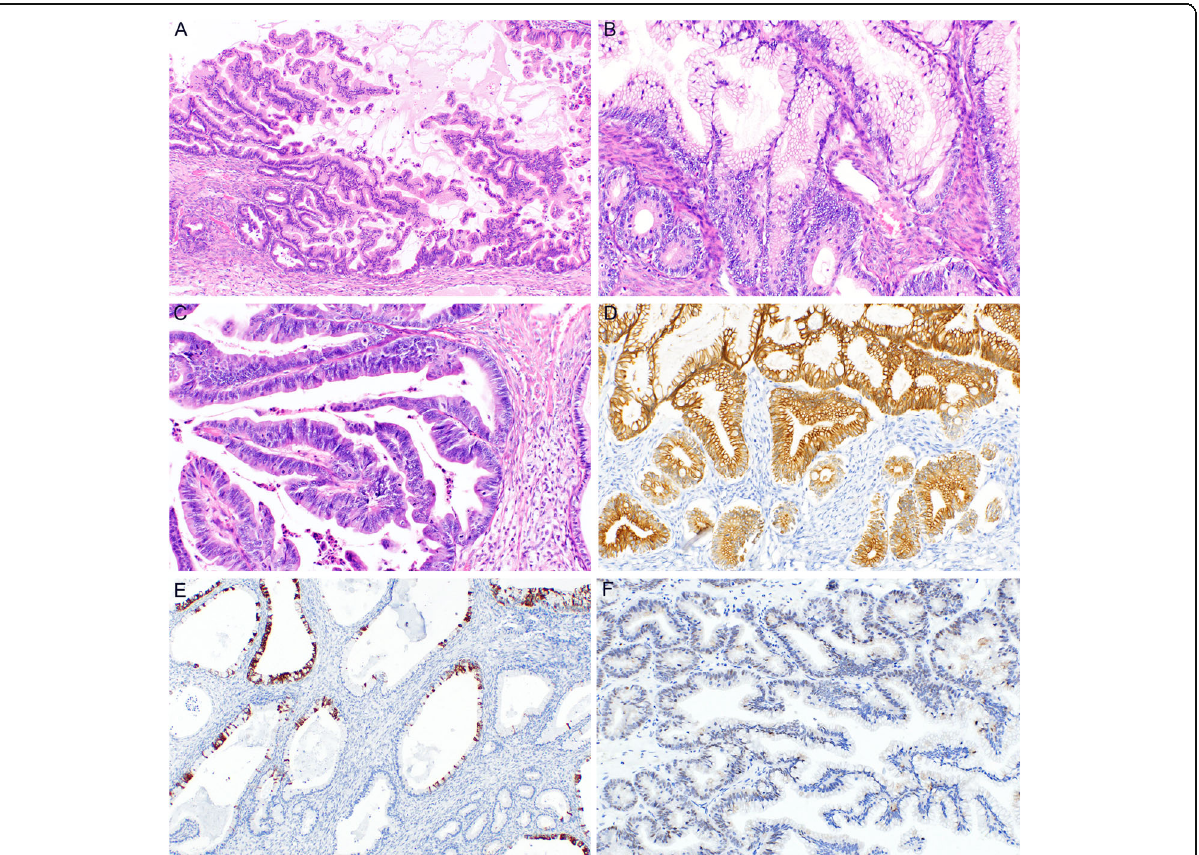
Fig. 1 Mucinous borderline tumor (MBT). Intracystic epithelial proliferation of gastrointestinal-type epithelium with villoglandular arrangement ( a ) (H&E, 100x). Tumor structures showing increased proliferative activity in the crypts with mitoses and mild nuclear atypia, whereas other parts of the villoglandular structures consist of more mature cells ( b ) (H&E, 200x). MBT with intraepithelial carcinoma consisting of tumor cells with marked nuclear atypia and increased mitotic activity ( c ) (H&E, 200x). Diffuse immunohistochemical expression of cytokeratin 7 ( d ) (200x) and focal expression of cytokeratin 20 ( e ) (200x). MBT with focal, mostly weak expression of PAX8 ( f )